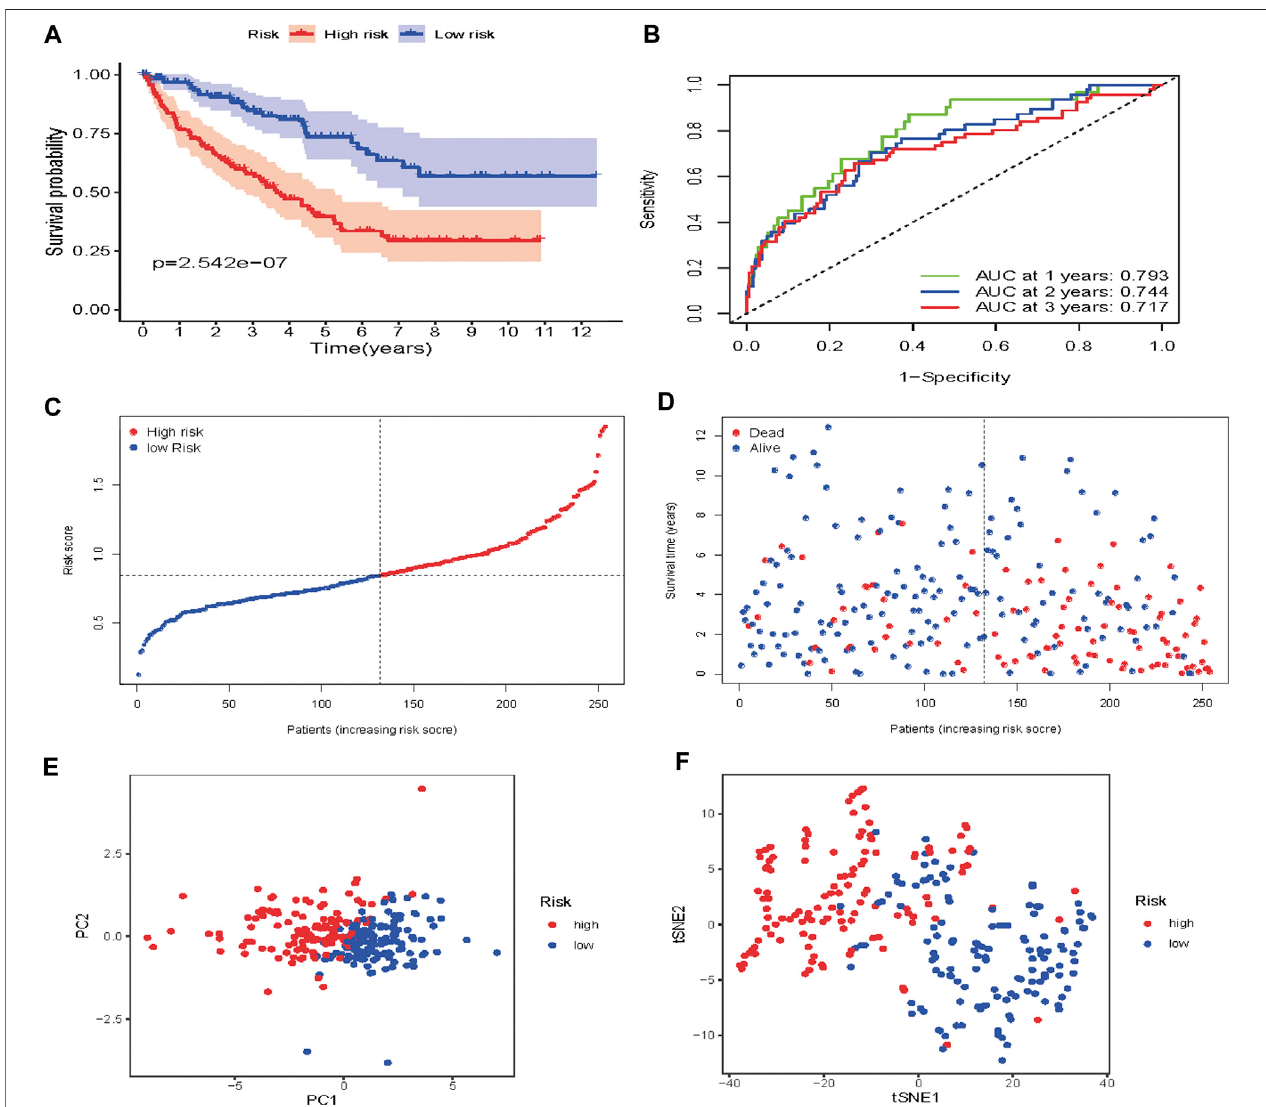
FIGURE 9 | Risk score analysis of the seven-gene prognostic model in the validation cohort (A) Kaplan-Meier curves for the OS of patients in the high-risk group and low-risk group (B) AUC of time-dependent ROC curves veri fi ed the prognostic performance of the risk score model (C) Distribution and median value of the risk scores (D) Distributions of OS status, OS and risk score in the validation cohort (E) t-SNE analysis of the validation cohort (F) PCA plot of in the validation